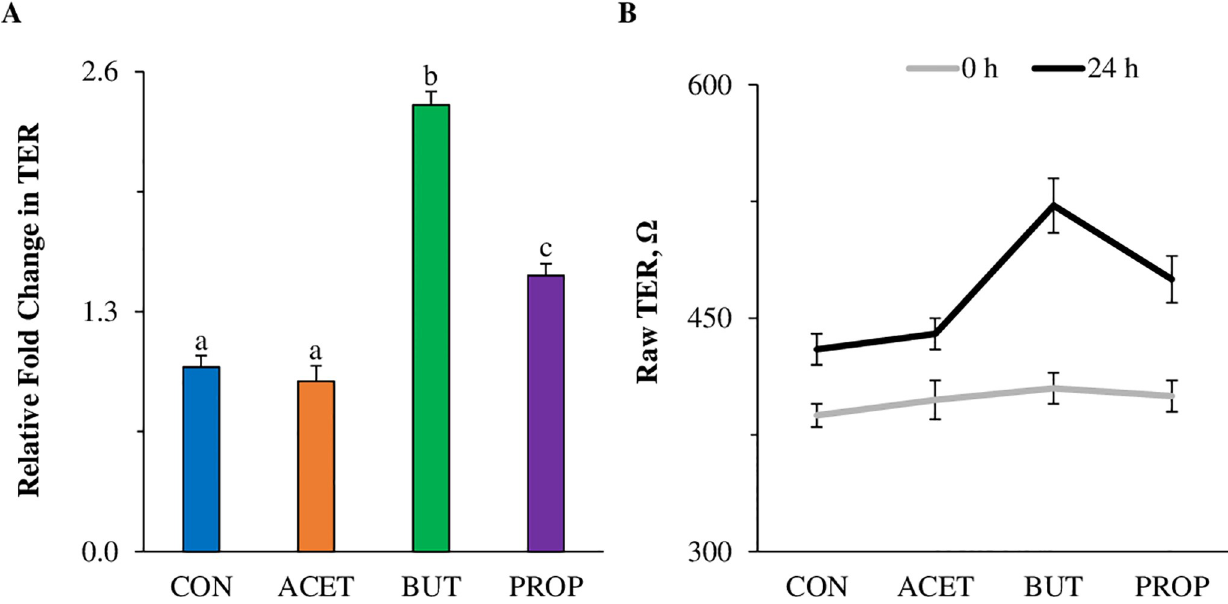
Fig 8. Effect of 24 h treatment with 10 mM acetate (ACET), butyrate (BUT), or propionate (PROP) on (A) epithelial barrier function of human duodenal enteroids as measured by TER compared to controls (CON). Values are represented as relative change in TER at time 0 and time 24 h after treatment. (B) Raw TER values at 0 h and 24 h post-treatment. Treatments are compared to controls (CON) which are set to 1.0 and superscripts (a,b,c,d) indicate statistical significance between treatments at P < 0.05, n = 4.